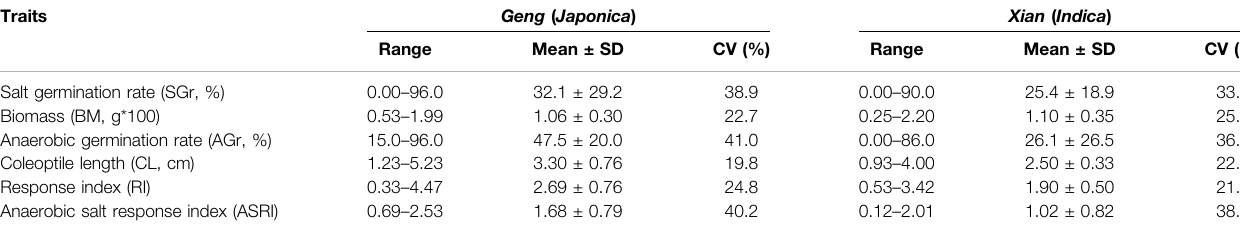
TABLE 1 | Performances of salt tolerance related traits measured at germination under salinity and anaerobic stresses. Traits